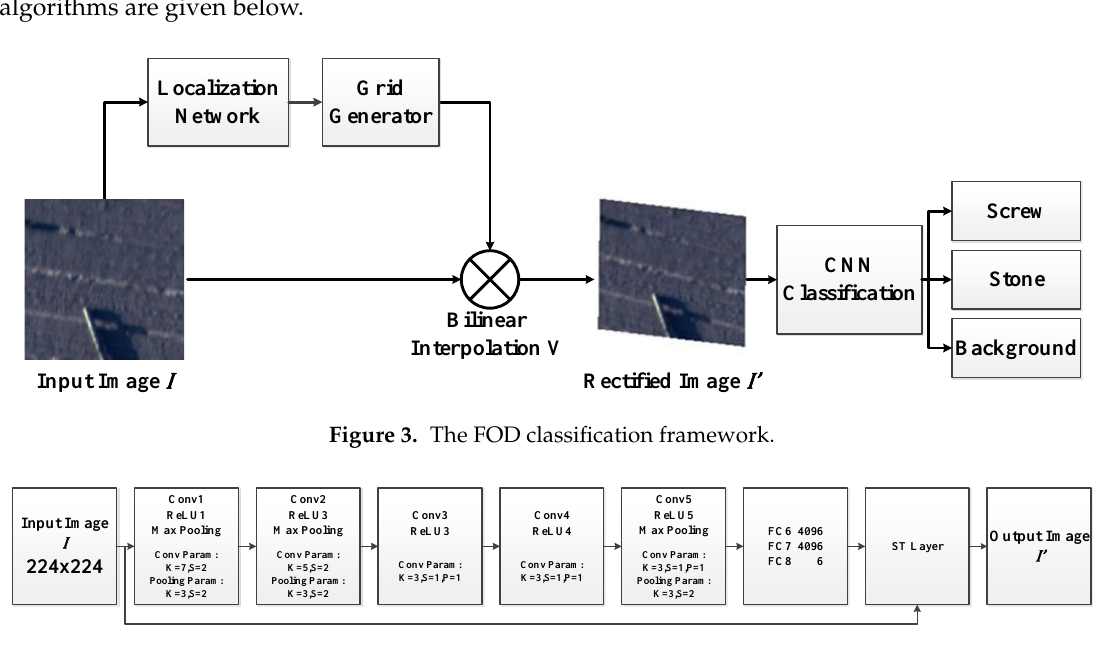
Figure 4. The architecture of spatial transformer